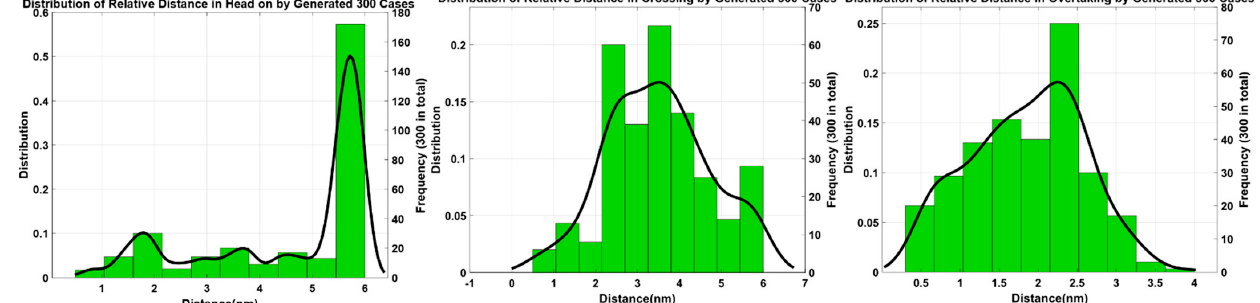
Figure 13. Distributions of initial relative speed for the 900 (300 each encounter) virtual scenario cases complying to the real AIS data in Figure 7. This indicates that our scenario generation program can create scenarios to simulate the real navigation situation Laotieshan area. Table 4. The virtual scenarios generated for head-on encounter. Head-On Virtual Scenarios Case No. Y (nm) X (nm) Heading (°) Velocity (kn) DCPA (nm)